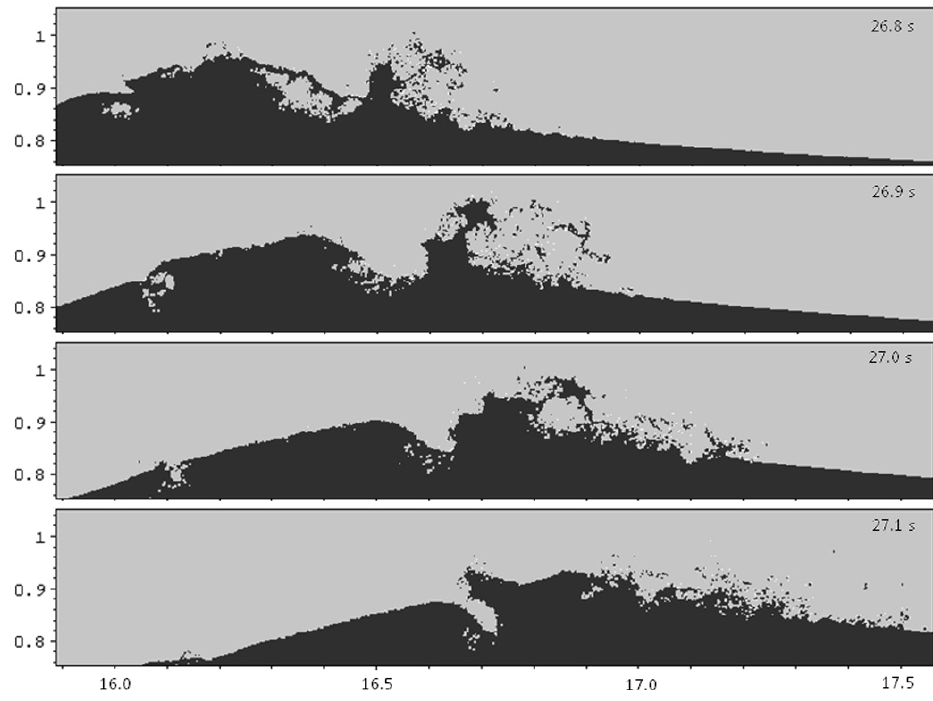
Fig. 10. The wave is collapsing. The jet from the splash-up creates another splash-up